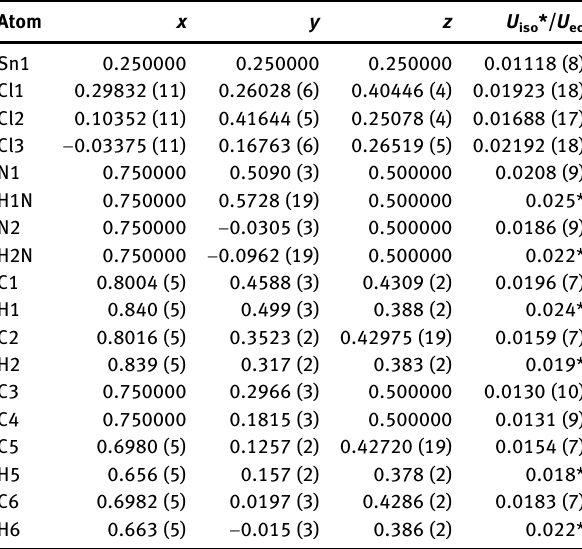
Table  : Fractional atomic coordinates and isotropic or equivalent isotropic displacement parameters (Å 